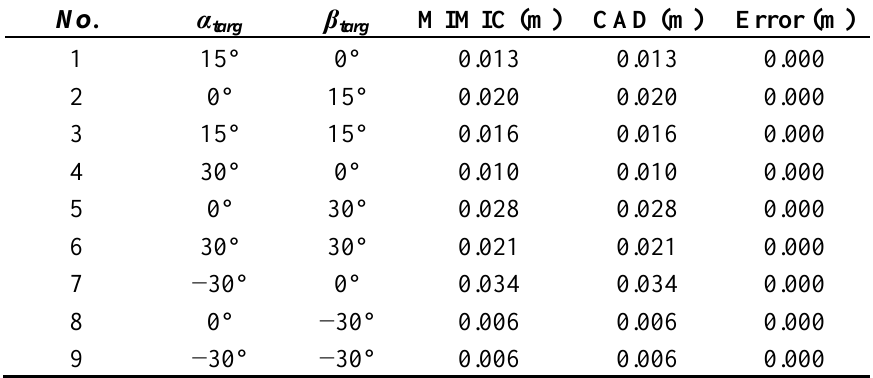
Table 4. Point spacing-The point spacing calculated by MIMIC validated using manual measurements from a constructed CAD model for a selection of horizontally rotated ( α and vertically rotated ( β ) surfaces. The simulated scanner height was 3.1 m, and a θ targ of 0.12° was